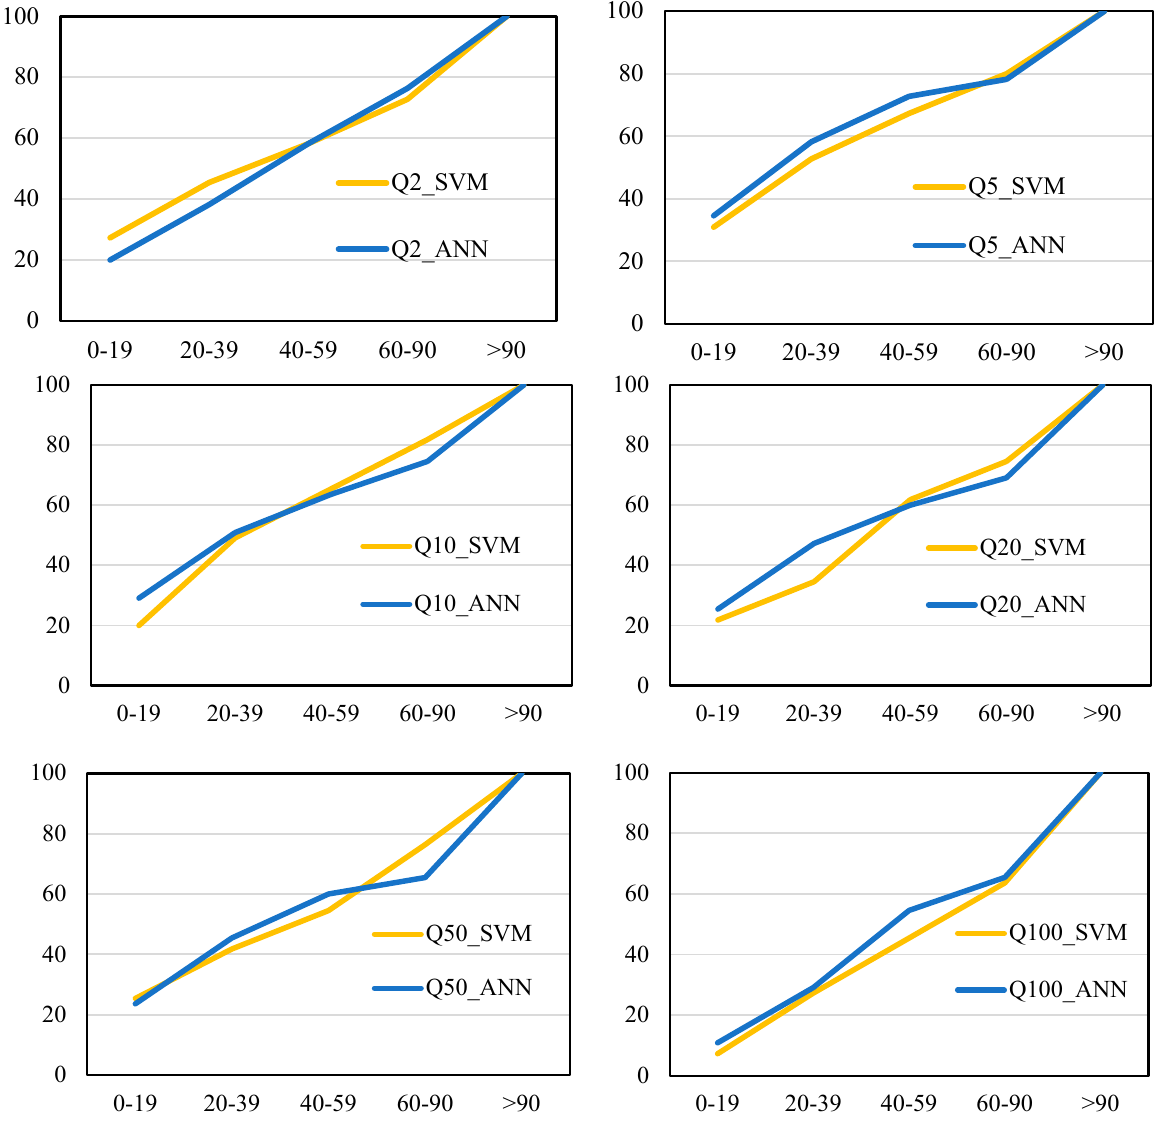
Figure 10. Plot of cumulative percentage of stations based on Abs RE values for SVM and ANN